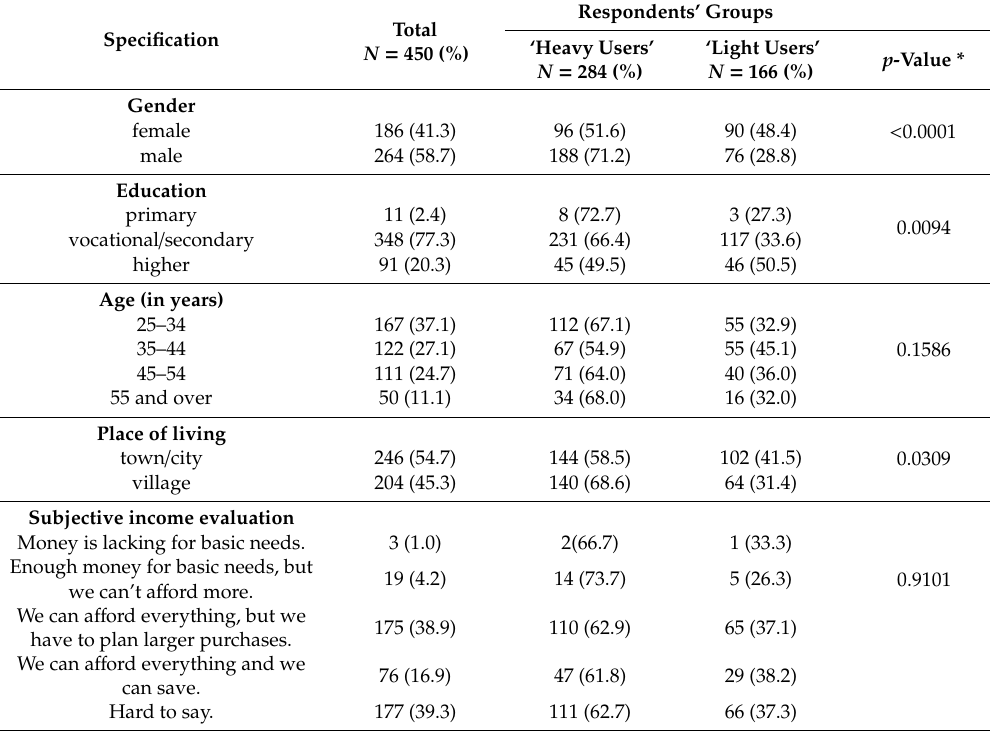
Table 1. Selected socio-demographic characteristics of the